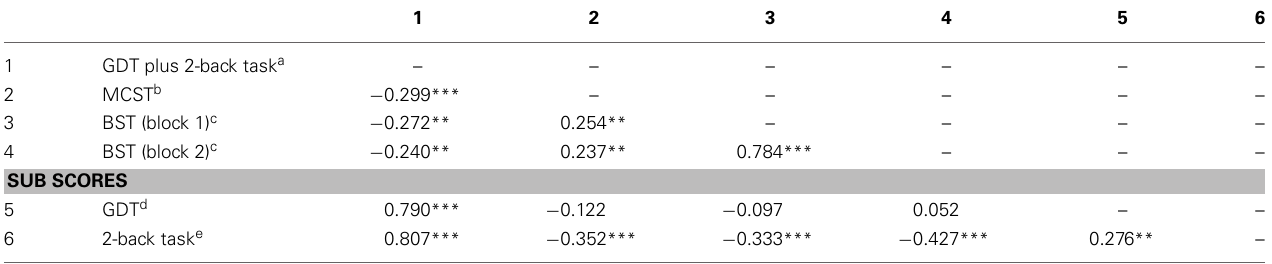
MCST, Modified Card Sorting Test; BST, Balanced Switching Task. a Mean of correct responses in the 2-back task and standardized expected total capital (percentages). b Frequency of perseverative errors (raw score). c Deviation score (relative frequencies).